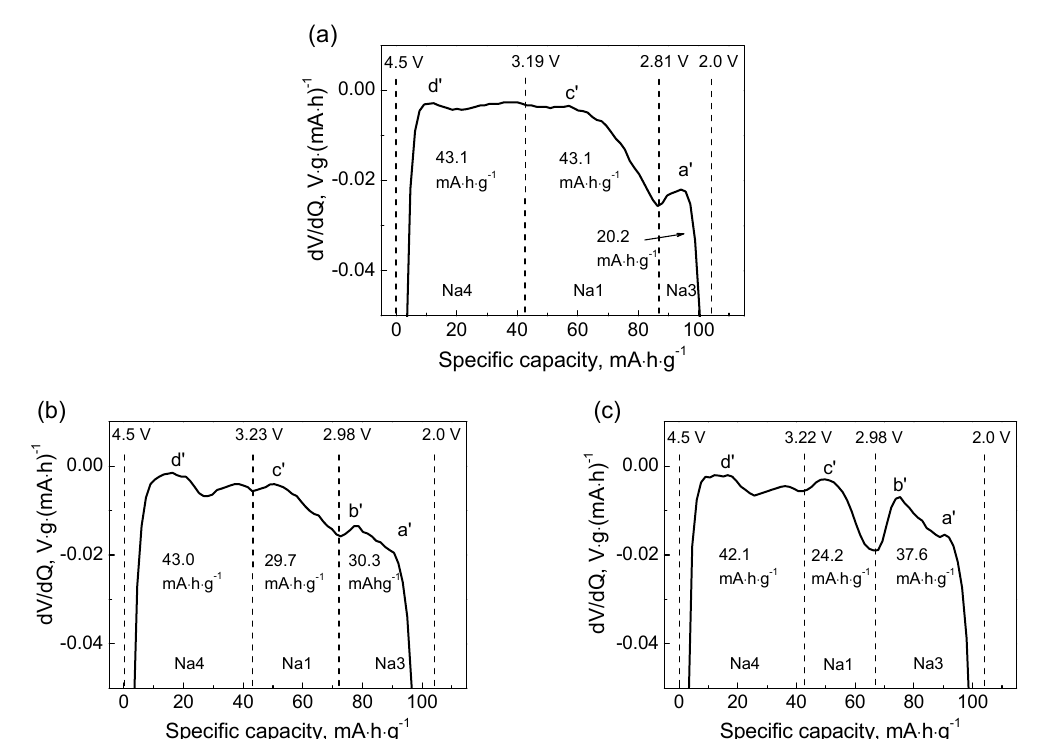
Figure 5. dV / dQ vs. voltage plots for ed-NFPP / Li ( a ), NFPP / Li ( b ) and ed-NFPP / Li-Na ( c Figure 5. dV/dQ vs. voltage plots for ed-NFPP/Li ( a ), NFPP/Li ( b ) and ed-NFPP/Li-Na ( c ).